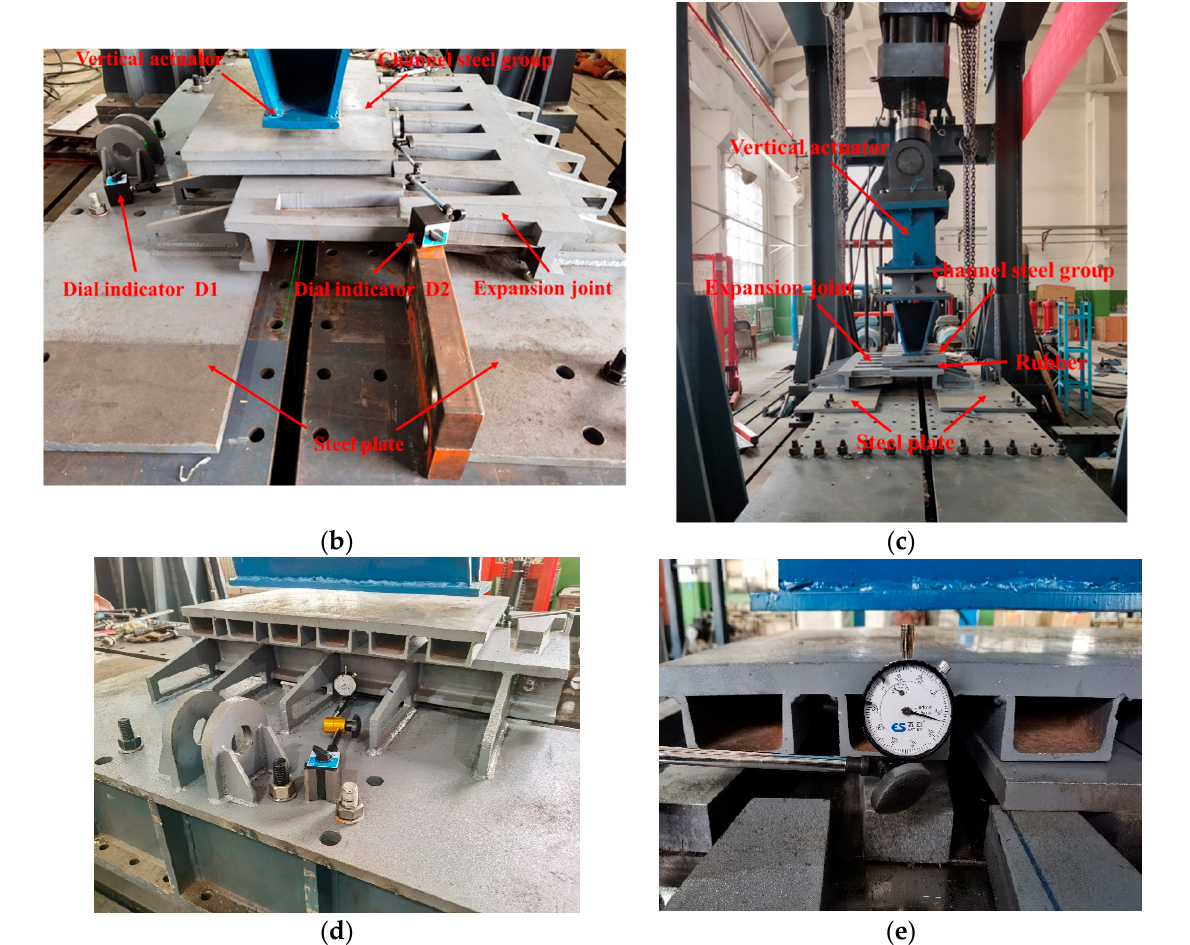
Figure 20. The layout of tests: ( a ) Maximum opening state of the expansion device, ( b ) The set-up of the load-bearing test, ( c ) The layout of fatigue test, ( d ) Installation of Dial indicator D1, ( e ) Installation of Dial indicator D2.